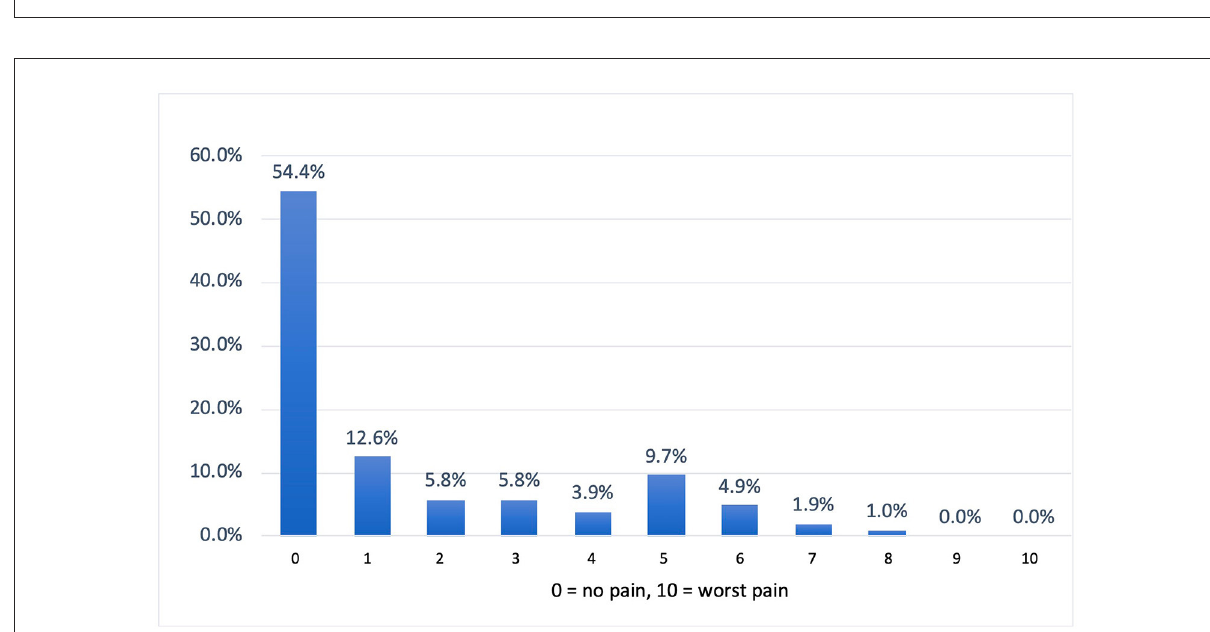
FIGURE1 Type of mask used and incidence (%) of adverse skin reactions.